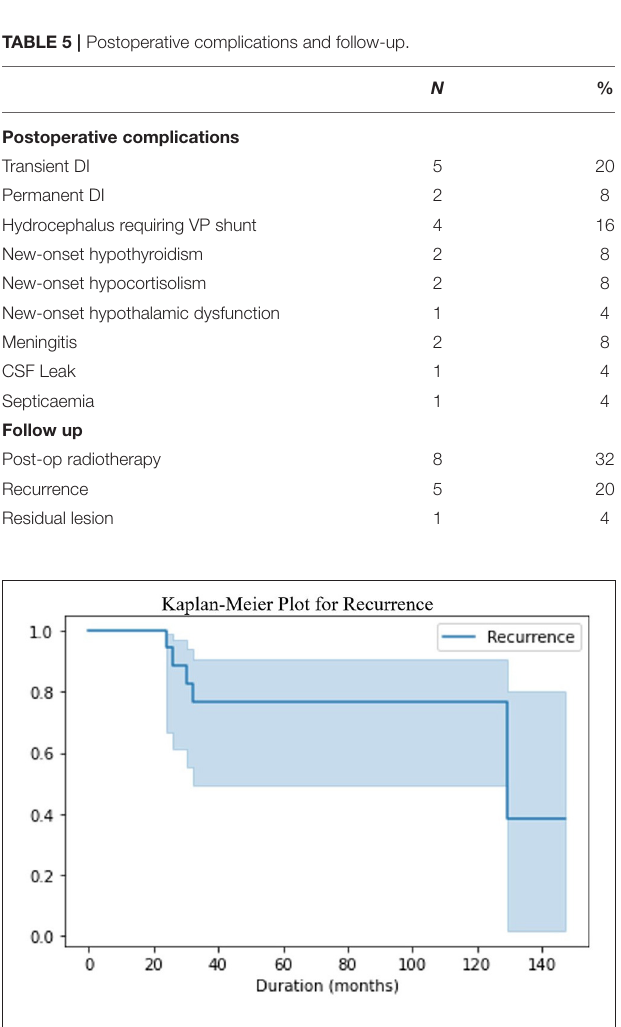
TABLE 5 | Postoperative complications and follow-up.